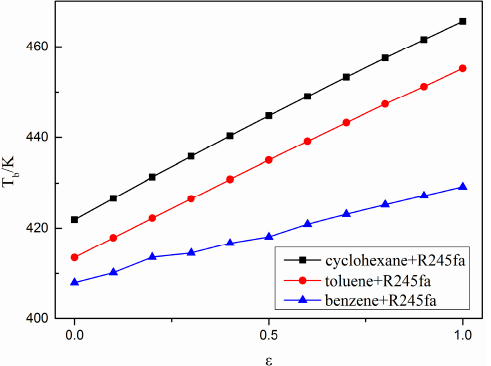
Figure 4 . Effect of regenerator efficiency on heat absorption of low temperature cycle evaporator.